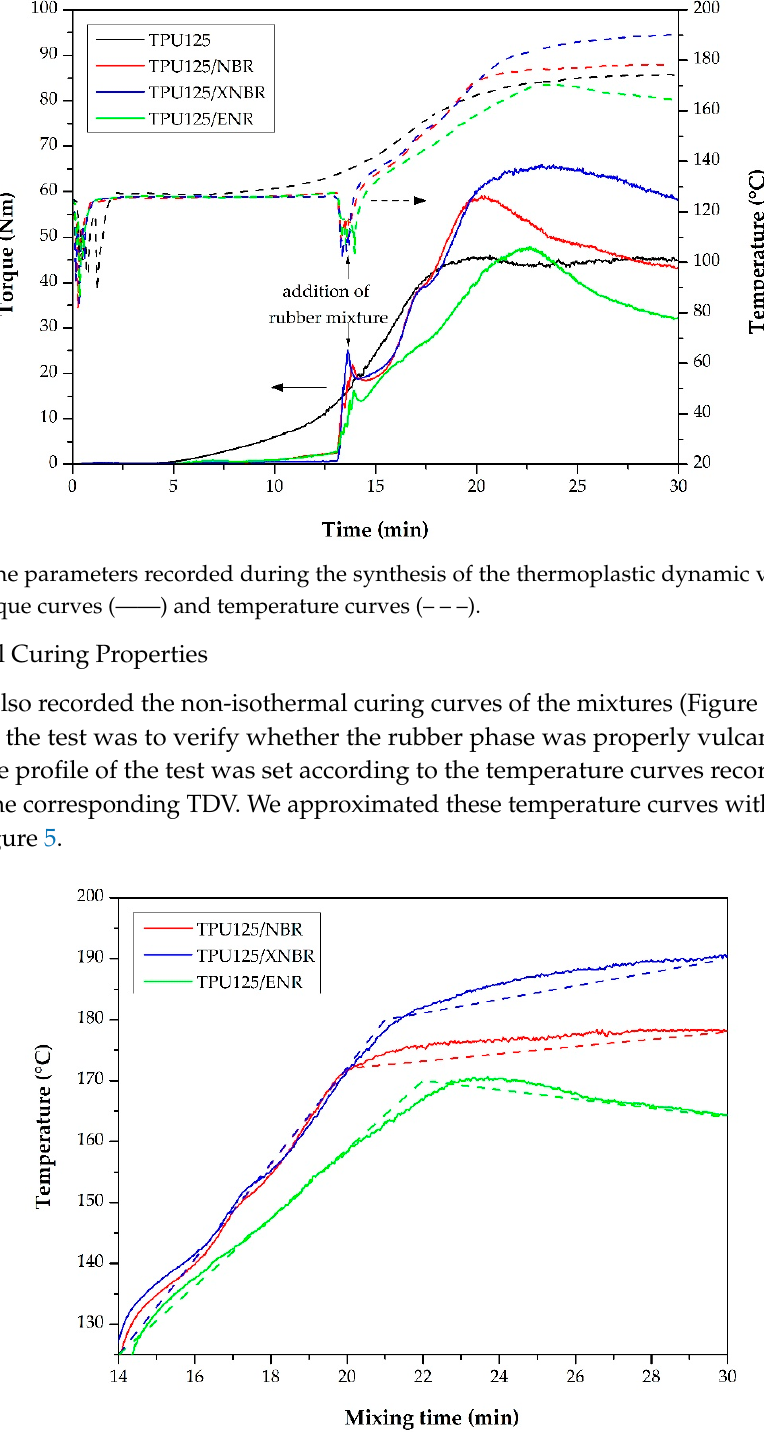
Figure 4. The parameters recorded during the synthesis of the thermoplastic dynamic vulcanizates (TDVs): torque curves ( ) and temperature curves (    ).